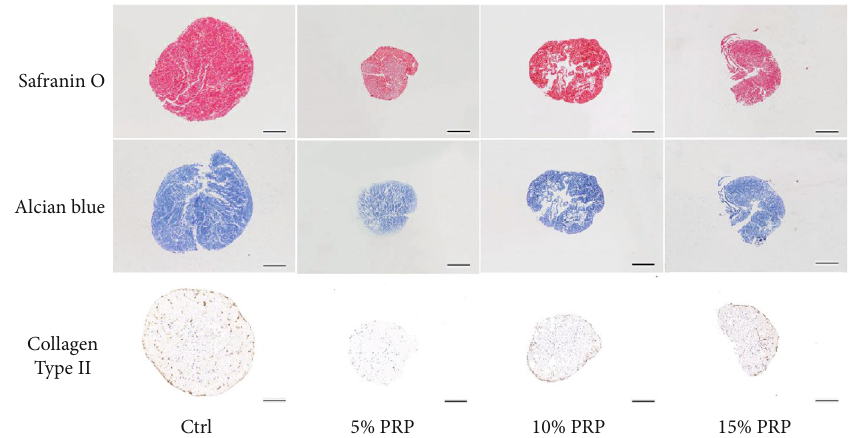
Figure 6: Histological evaluation of aggrecan and collagen type II deposition in BMSC pellets from four di ff erent groups after 3-week culture in vitro . Scale bar = 500 μ m .